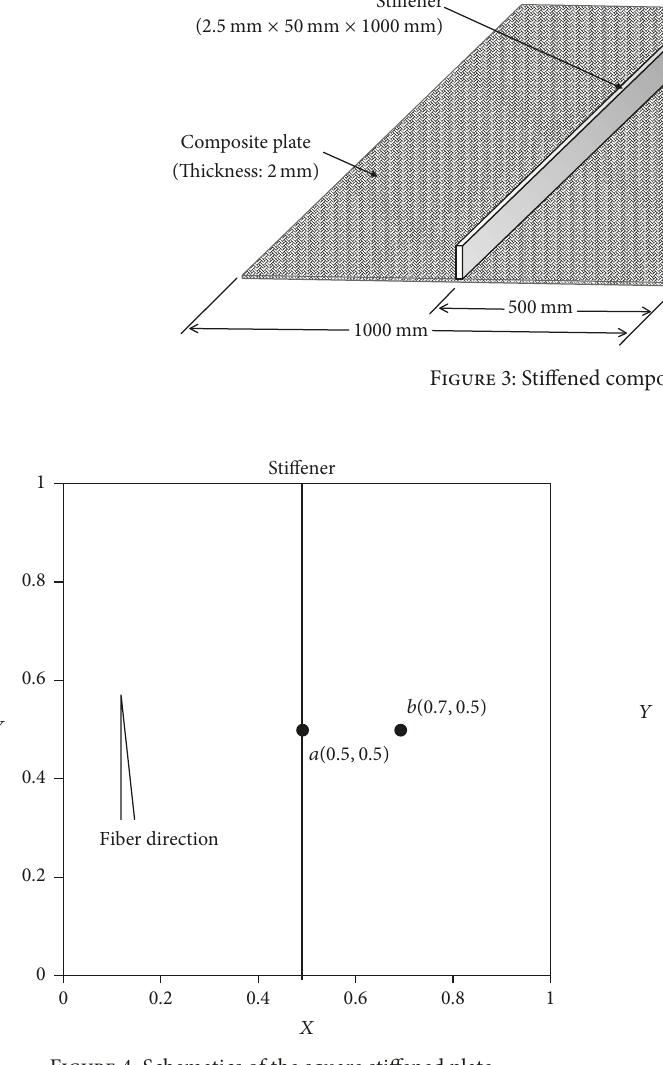
Figure 4: Schematics of the square stiffened plate.